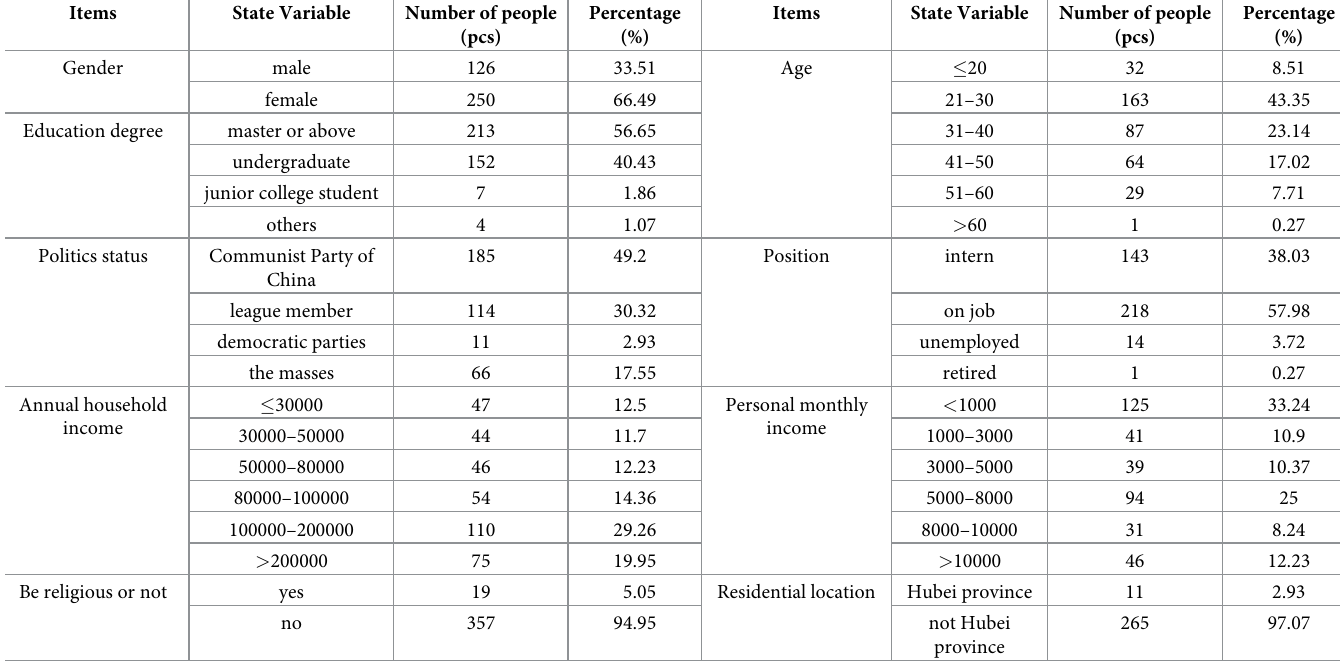
Table 2. Statistics for basic characteristics of samples.